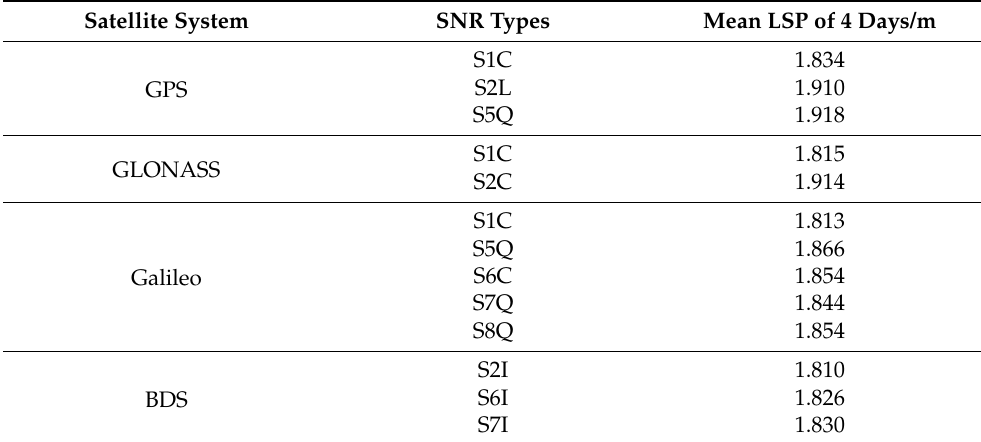
Figure 10. The snow-free surface reflector height reference value of multi-GNSS and multi-frequency LSP analysis results. Table 2. Multi-GNSS and multi-frequency LSP mean values of the snow-free reflector